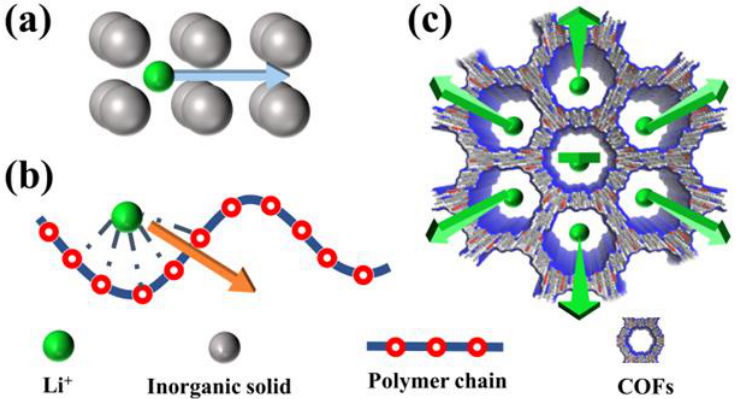
Figure 3. ( a ) Schematic diagram of the Li + ion transport mechanism in ( a ) SIEs; ( b ) SPEs; ( c ) COFs.